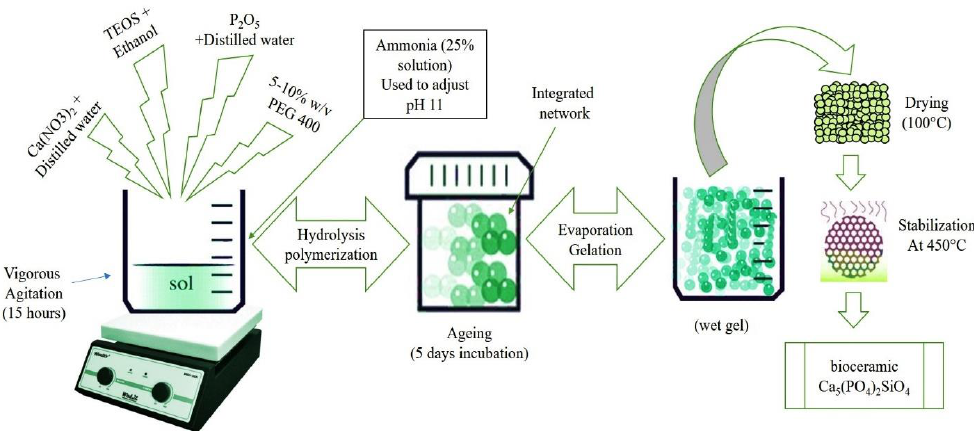
Figure 1. Synthesis of porous calcium phosphate silicate.